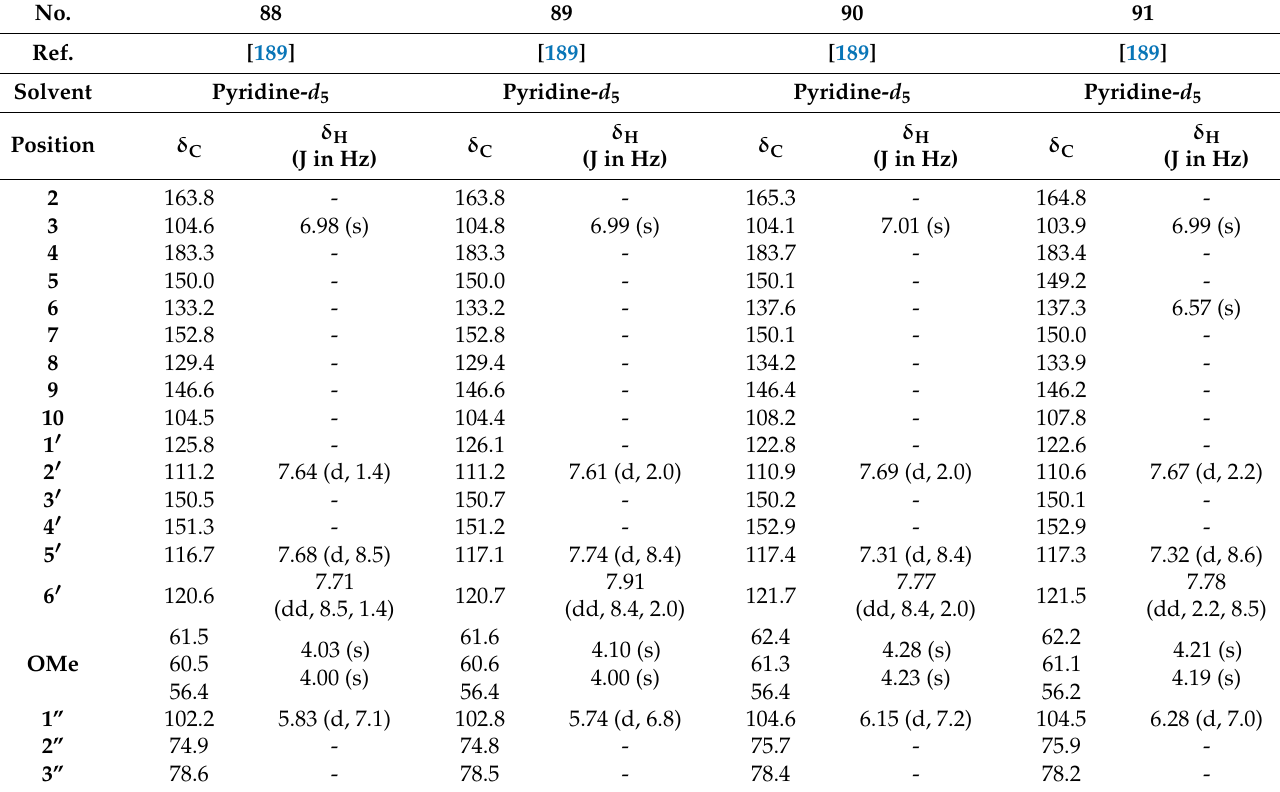
Table 18. Glycosylated flavones ( 88 – 91 ) extracted from Citrus